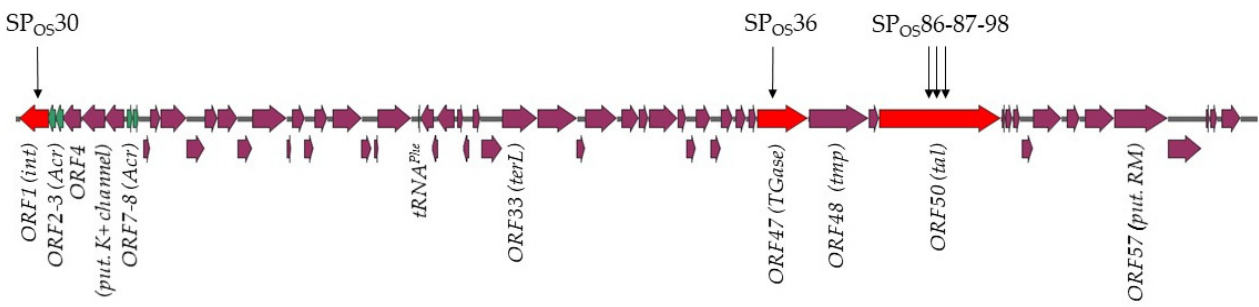
Figure 4. Auto-immunity and location of STS in O. sicerae UCMA15228. The genomic organization of the prophage genome targeted by the type I CRISPR system is shown. The location of the protospacers incorporated into the CRISPR locus as STS (SP OSI 30, SP OSI 36, SP OSI 86, SP OSI 87 and SP OSI 98) are indicated above the map. The four putative acr genes are in green. Tgase: Transglycosylase.